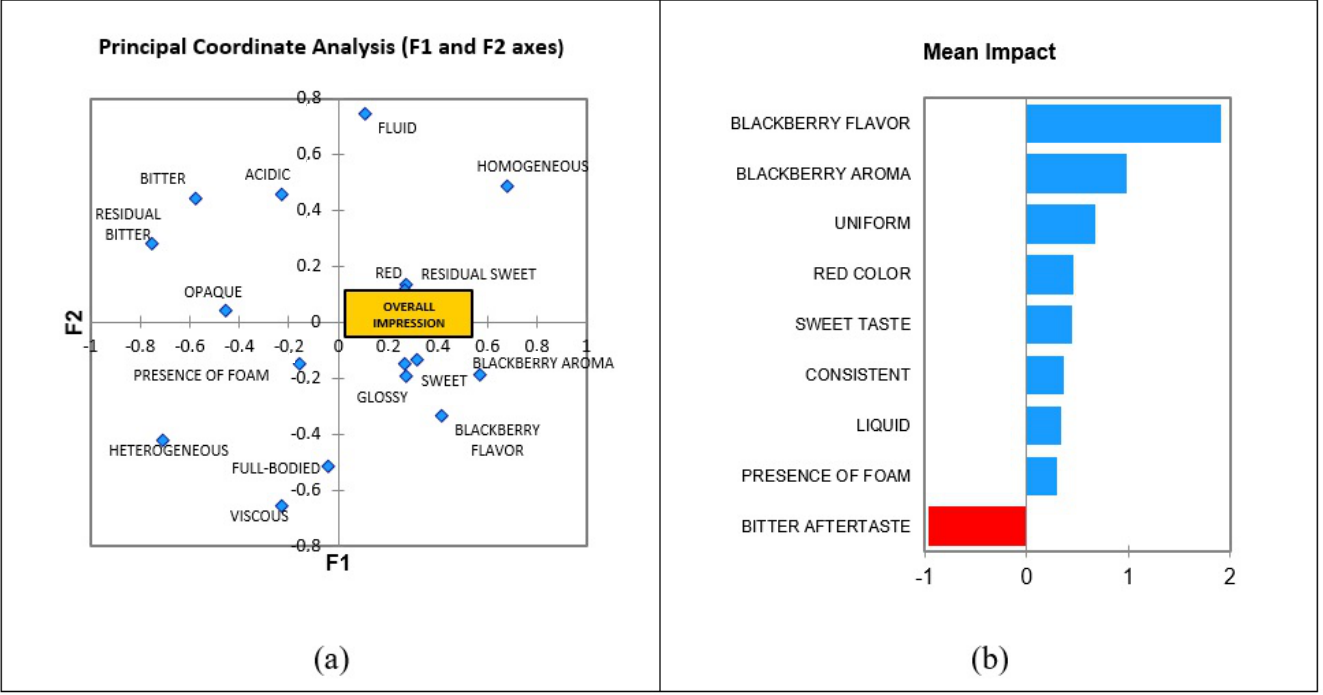
Figure 7. Principal coordinate analysis ( a ) and mean impact of blackberry nectar ( b ). Blue diamonds are words used in the